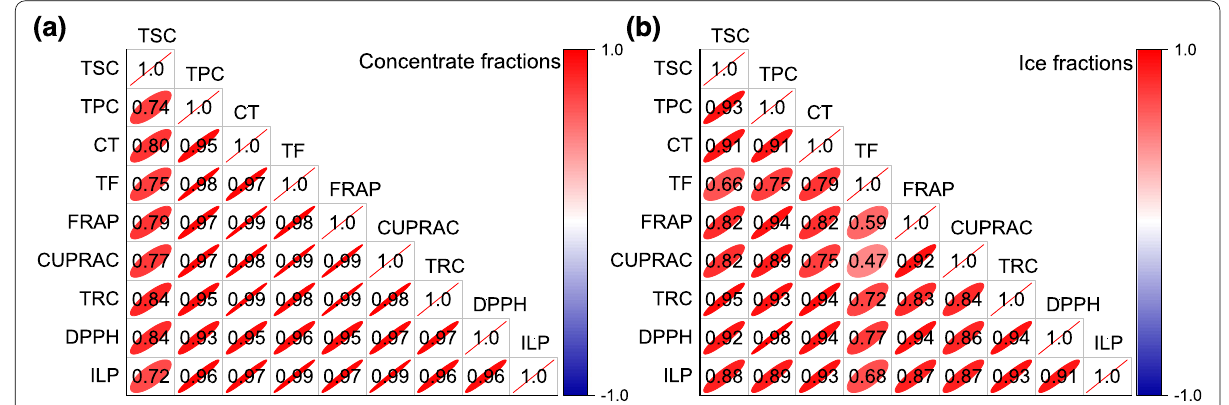
Fig. 3 Correlogram for total solids content (TSC), total phenolic compounds (TPC) and the antioxidant activity of concentrate and ice fractions of pecan nut cake beverage over multi-stage block freeze